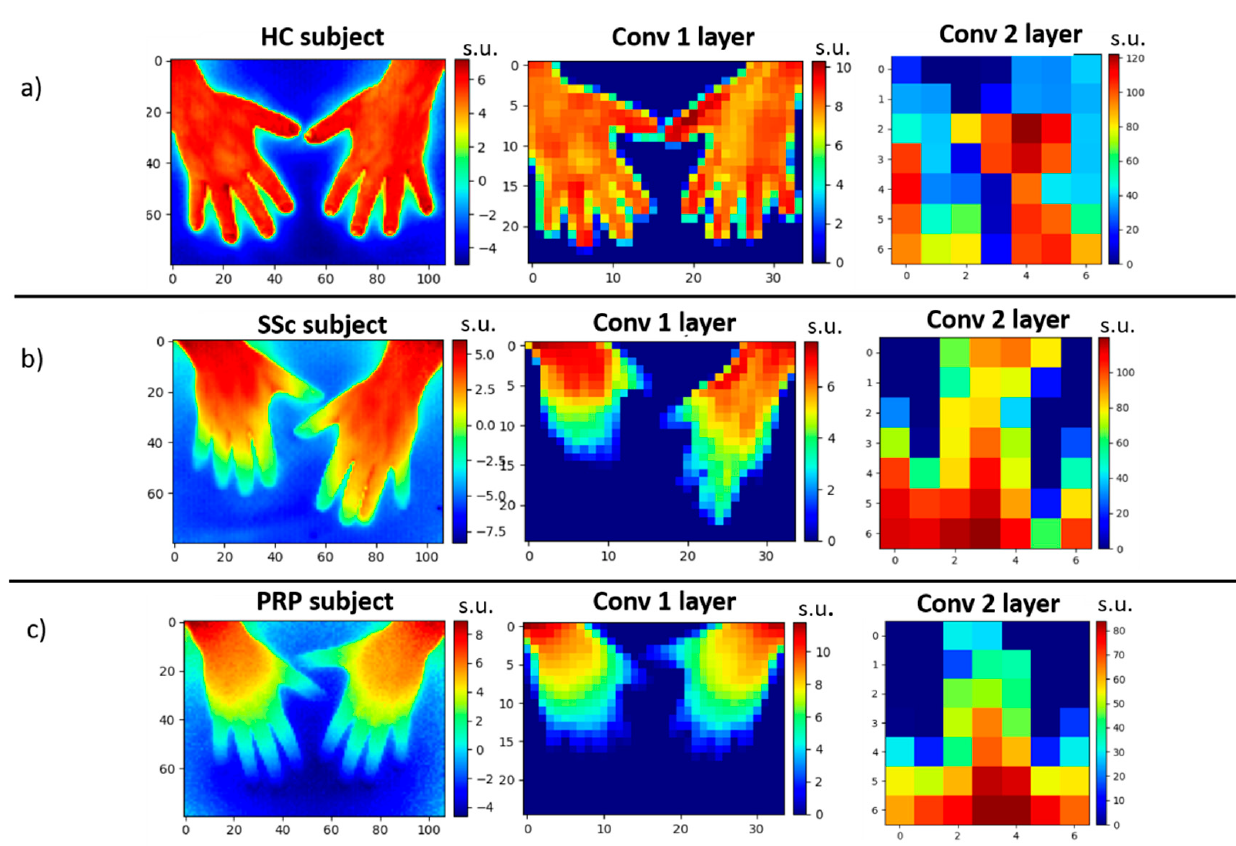
Figure 3. Deep Convolutional Neural Network (DCNN) feature maps. ( a ) Input image of a representative healthy participant within the dataset together with the features map resulting from the first two convolutional layers (s.u. = standardized units). ( b ) Input image of a representative systemic sclerosis (SSc) participant within the dataset and the features map resulting from the first two convolutional layers. ( c ) Input image of a representative primary Raynaud’s phenomenon (PRP) participant within the dataset and the features map resulting from the first two convolutional layers. The images’ axes units represent the images’ pixels number.